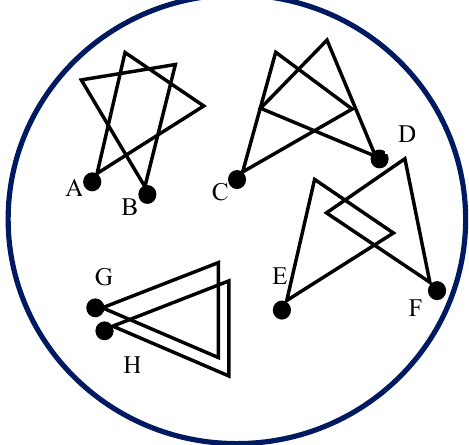
Figure 6. Overlapped FoVs of sensor nodes in a network area.